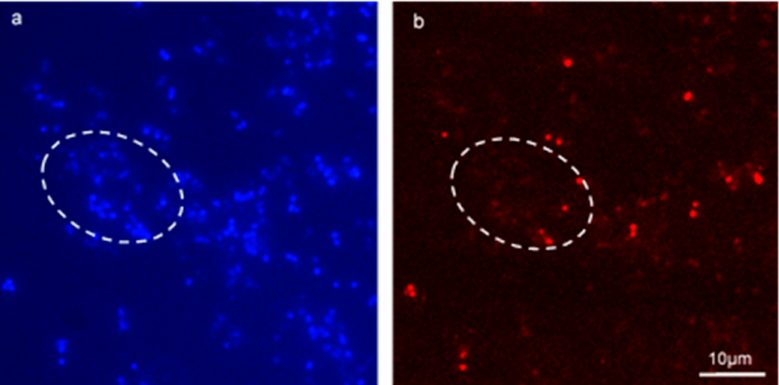
Figure 6. Application of FISH on a mixed-species enterococcal conjugation reaction inside biofilm successfully identified transconjugants. ( a , b ) are fluorescent micrographs of a conjugation reaction between E. faecalis MF06036 and E. faecium ST01109 Rif inside biofilm. Biofilm was created, and enterococci allowed to conjugate for 24 h. Post-conjugation, biofilm was treated with tetracycline (30 µ g/mL) for 24 h, and then treated with lysozyme (2 mg/mL) for an additional 24 h. ( a ) 100 × fluorescent micrograph showing Hoechst staining of tetracycline and lysozyme treated biofilm post- enterococcal conjugation. ( b ) FISH staining of same region as ( a ) with probes specific for E. faecium only. White dashed ovoid depicts region of interest with total cell count stained blue ( a ) and stained red ( b ) with E. faecium cells